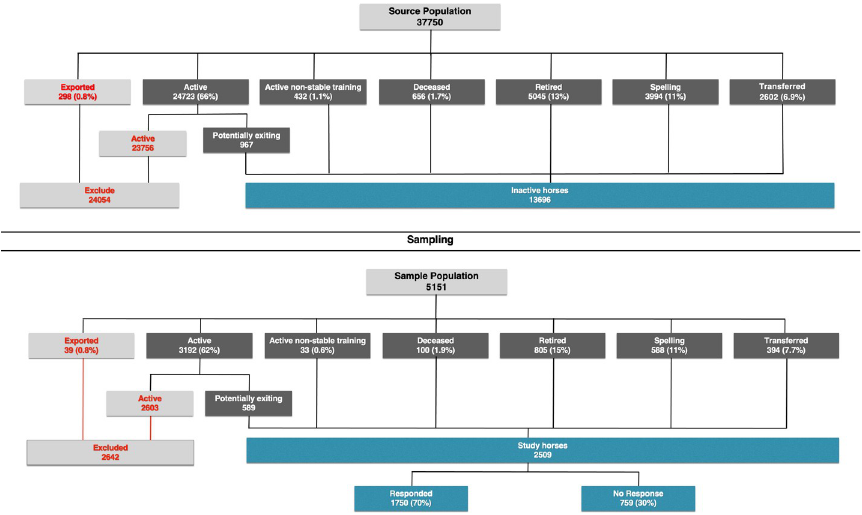
Fig 1. Flow chart of survey enrolment and response rate for the horses in 2017–2018 Australian Thoroughbred racing season.